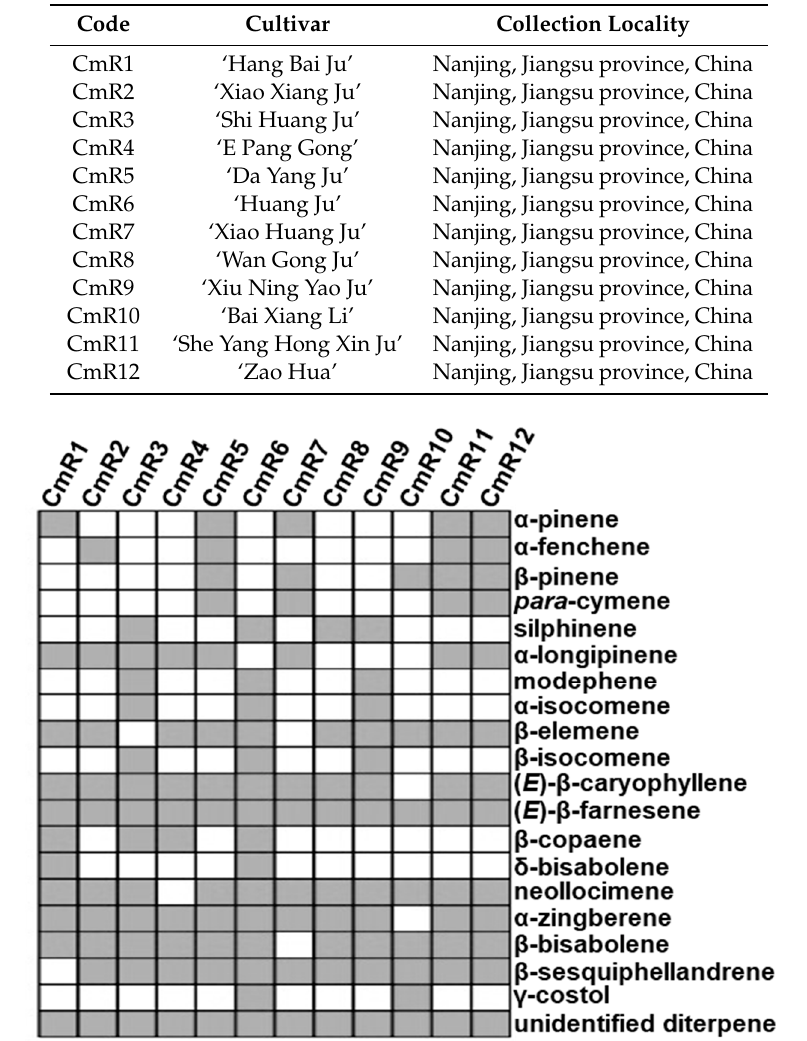
Figure 1. Presence / absence of individual terpenoids in roots of 12 cultivars of C. morifolium (CmR1 to CmR12). Gray and white rectangles denote the presence and absence of a terpenoid, respectively. CmR1–12 refer to the cultivar codes in Table 1.